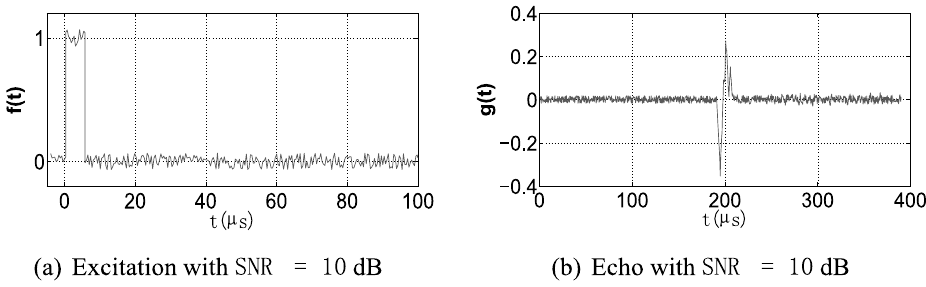
Fig. 21. Short rectangular incident pulse and corresponding echo, SNR = 10